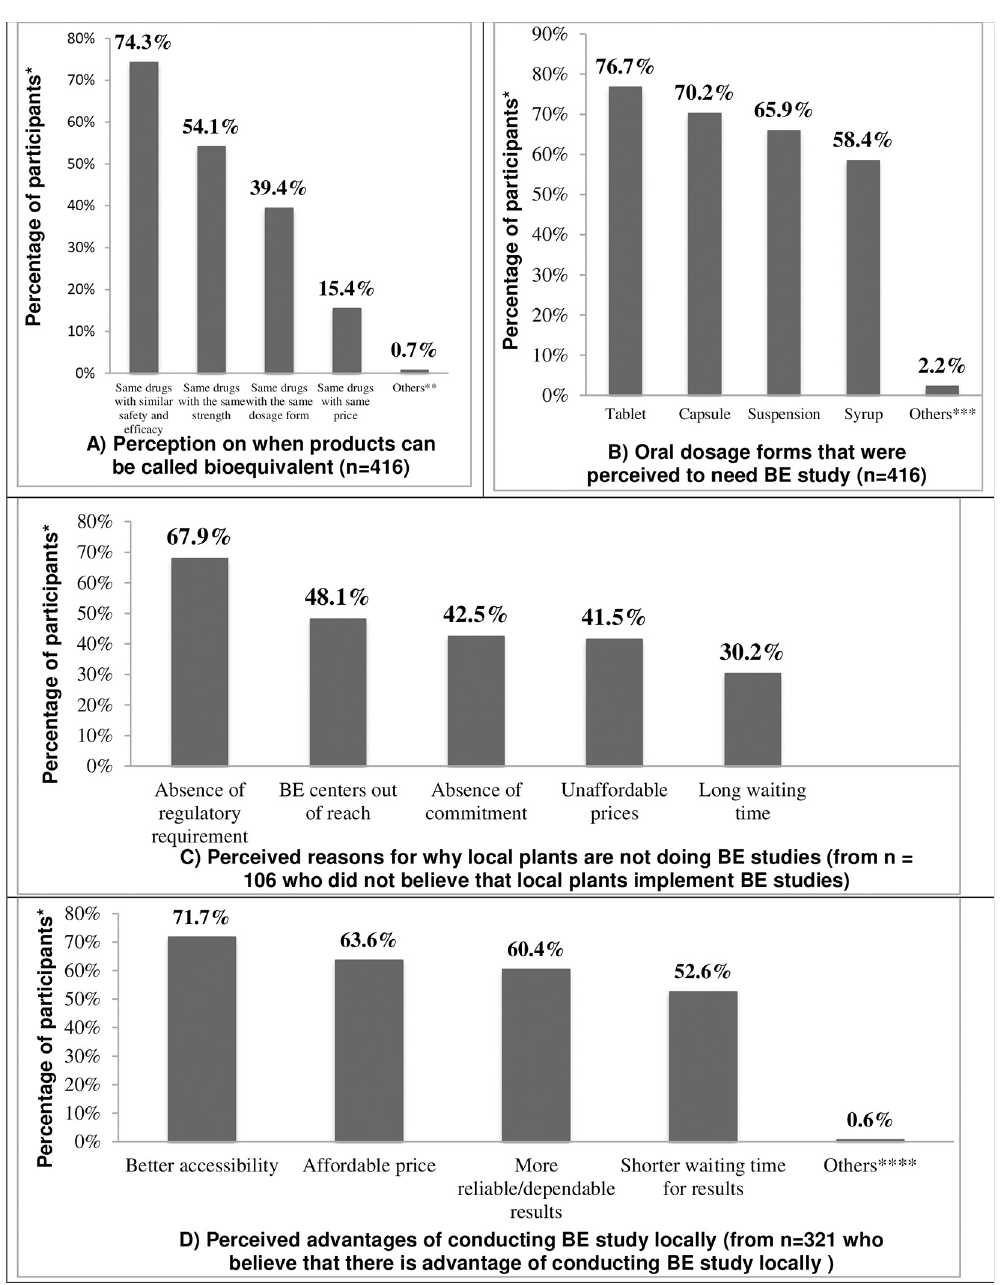
Fig 1. Respondents’ perception on BE studies and the advantages and challenges of doing BE studies locally. � Percentages do not add up to hundred because participants can select multiple responses. �� Other definition: same drug with different price, same drug with different brand. ��� Other dosage forms: products unrelated to the immediate release oral dosage forms. ���� Other advantages: economic gain for the country.